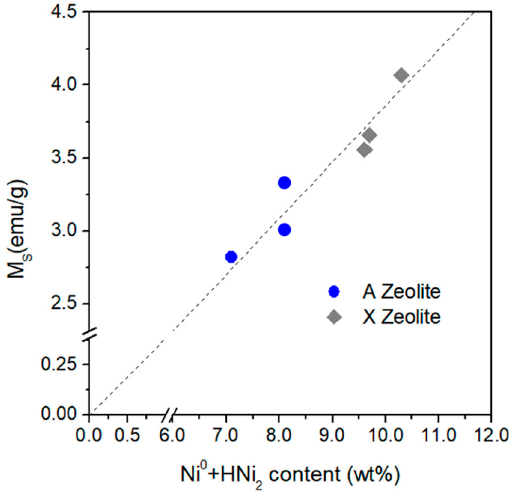
Figure 14. Room temperature saturation magnetization M s as a function of the total content of metallic Ni and hexagonal nickel hydride.